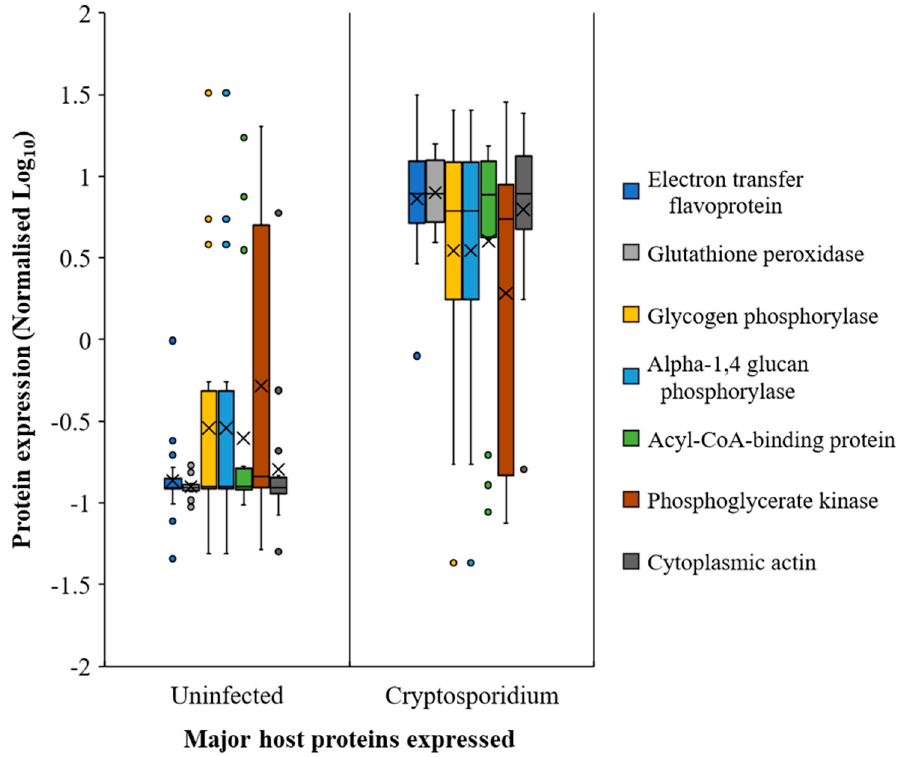
Figure 6. Most prominent host proteins expressed across the mouse intestine (both small and large intestine sections) upon Cryptosporidium infection. Note: Error bars represent standard deviation between the experimental replicates ( n = 25).